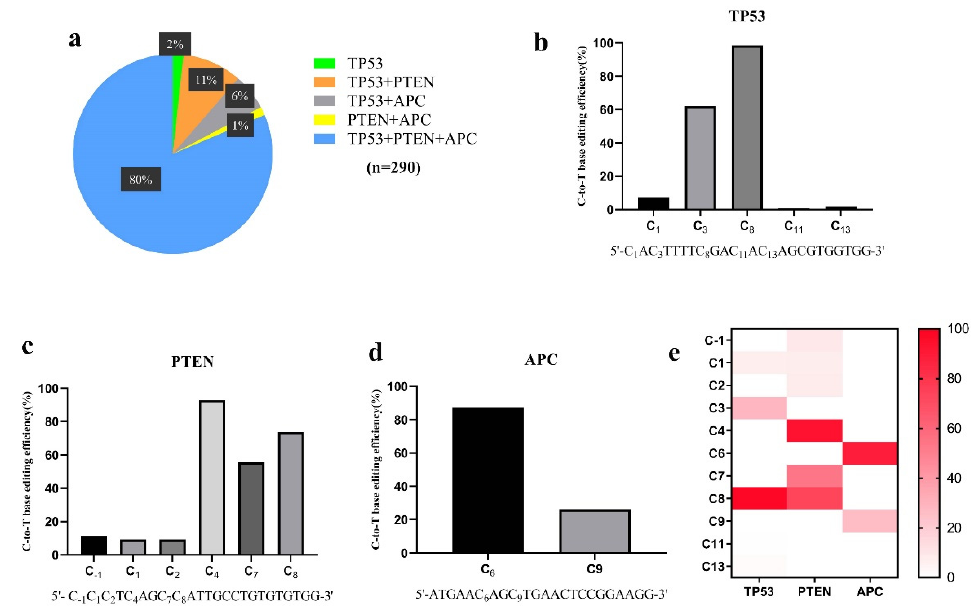
Figure 2. hA3A-BE3-Y130F-medidated C − to − T conversion in three tumor suppressor genes in PFFs.